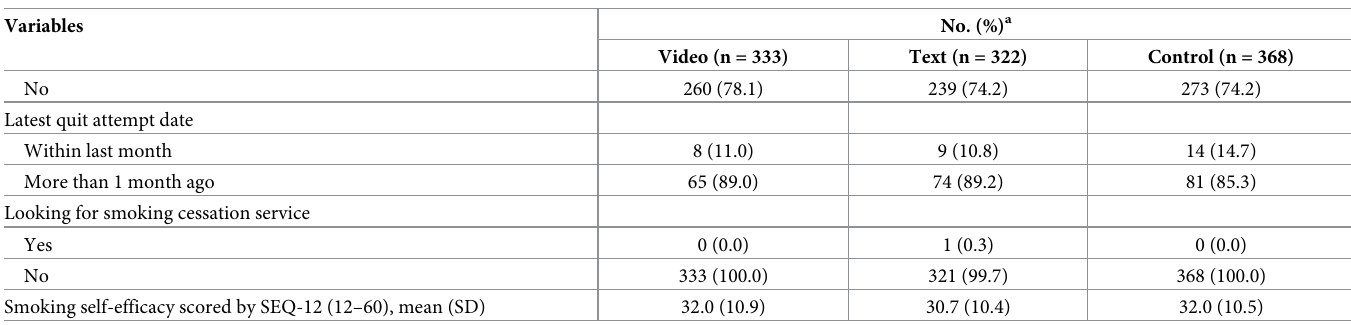
Table 2. Smoking cessation outcomes of participants in the video, text, and control groups. No./Total No. (%) P-Value for Video versus